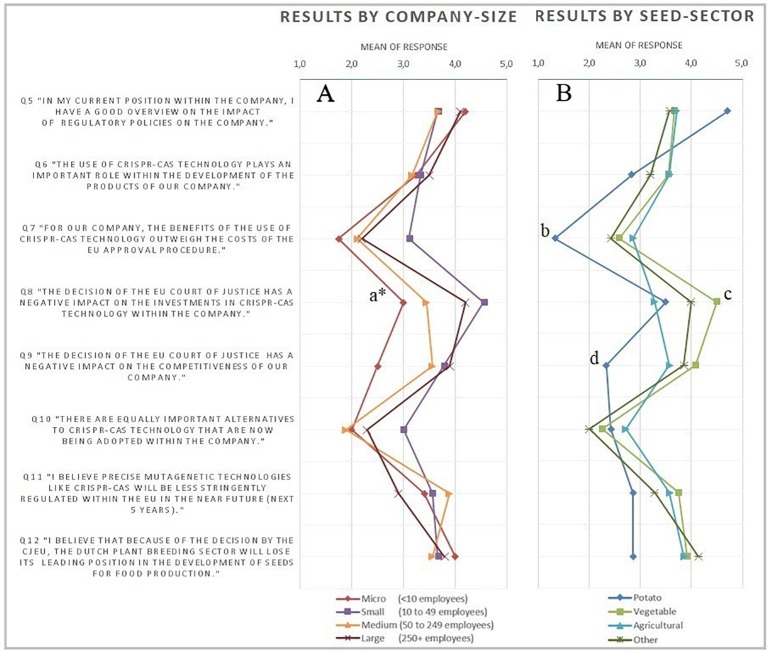
Overview of average results of the survey statements on a five-point Likert-scale, excluding not relevant (0) responses ranging from (1) strongly disagree to (5) strongly agree. Graph panel (A) gives the results differentiated by company size, whereas panel (B) differentiates the results on seed sector. Statistical results graph panel (A): a* = two-sided significant difference micro from rest (P < 0.05) and two-sided significant different distributions among all groups (P < 0.05). Statistical results graph panel (B): b = two-sided significant difference potato from all (P < 0.05). c = two-sided significant difference vegetable from all (P < 0.05). d = two-sided significant different potato from all (P < 0.05).